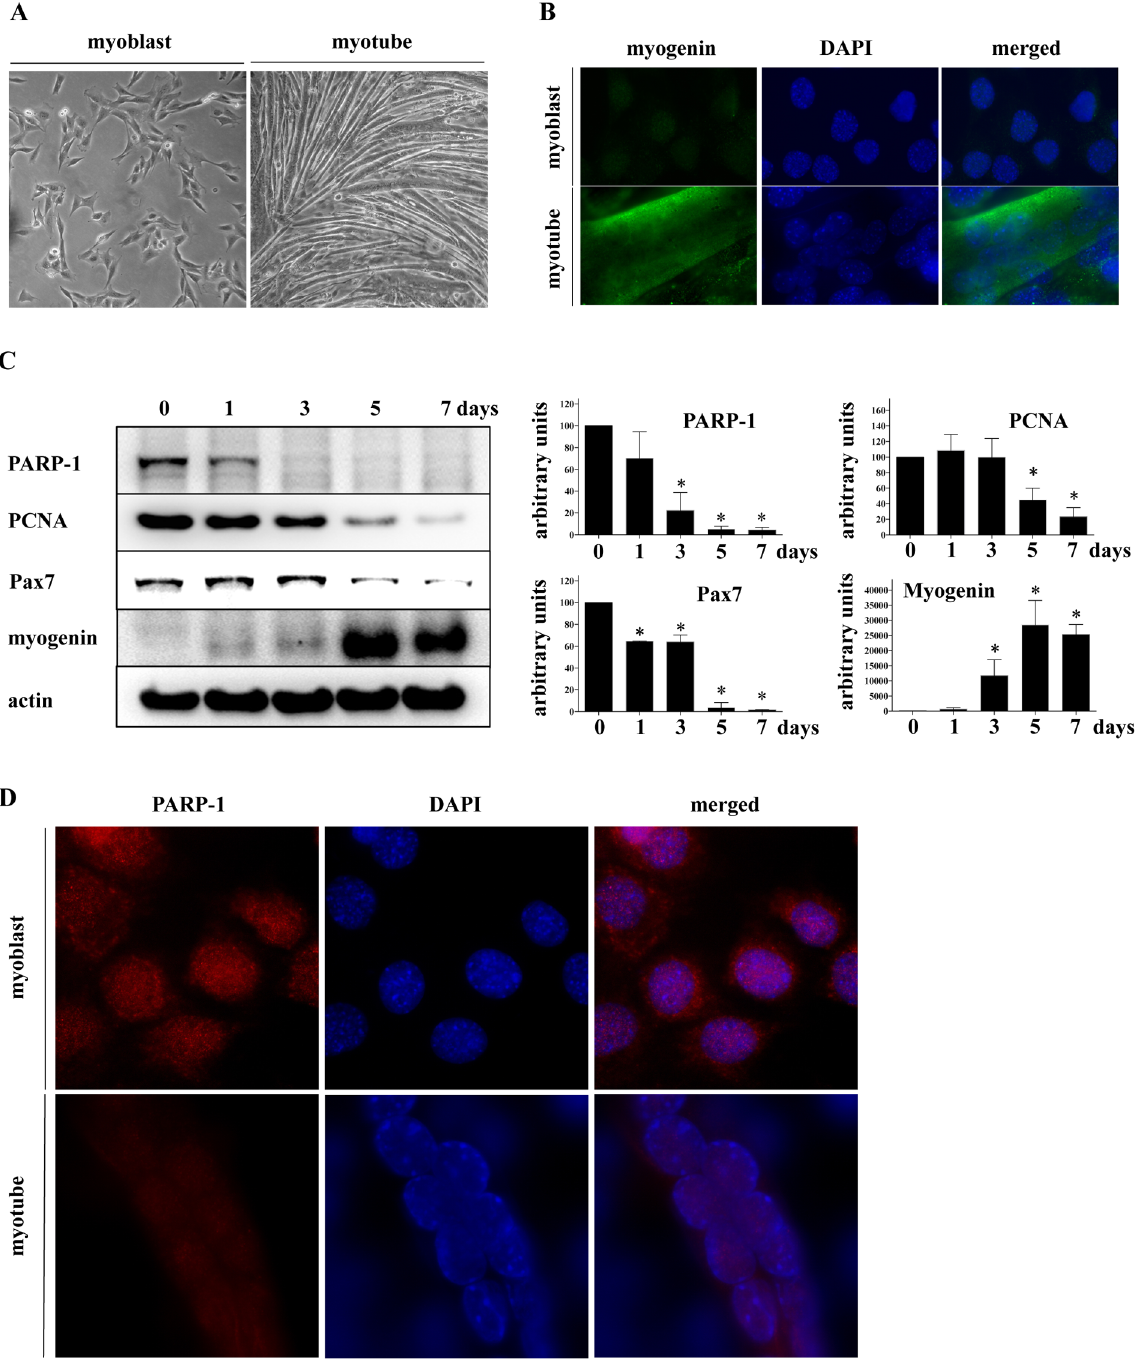
Fig 1. PARP1 level is reduced in myotubes. (A) Representative phase-contrast microscopy images of myoblasts and myotubes showing typical morphological differences. ( B ) Immunocytochemistry of the differentiation marker, myogenin, in myoblasts and myotubes. DAPI was used for nuclear counterstaining. Increased myogenin signal was detectable in the fully differentiated myotubes. (C) The effect of differentiation on protein expression of PARP-1 and the differentiation markers, PCNA, Pax7, and myogenin were monitored on Days 0 – 7 using whole cell extracts. Actin was used as a loading control. The relative quantity of proteins was calculated by densitometry and normalized to actin based on the analysis of three independent Western blots. * indicates p < 0.05 relative to myoblasts at Day 0 (100%). ( D) PARP-1 distribution in undifferentiated myoblasts and differentiated myotubes. DAPI was used for nuclear counterstaining. Decreased PARP-1 signal was detectable in the fully differentiated